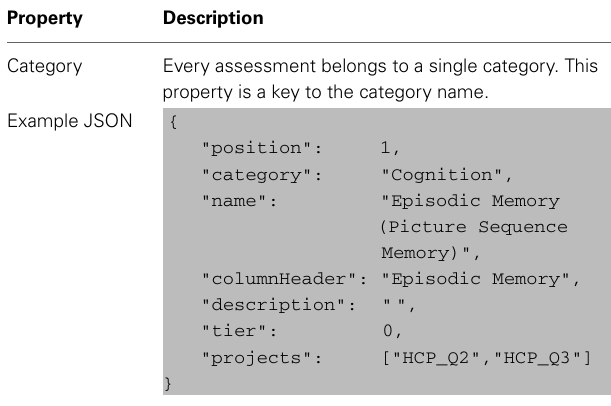
FIGURE 4 | Category, assessment, and attributes are browse-able through the ConnectomeDB dashboard.